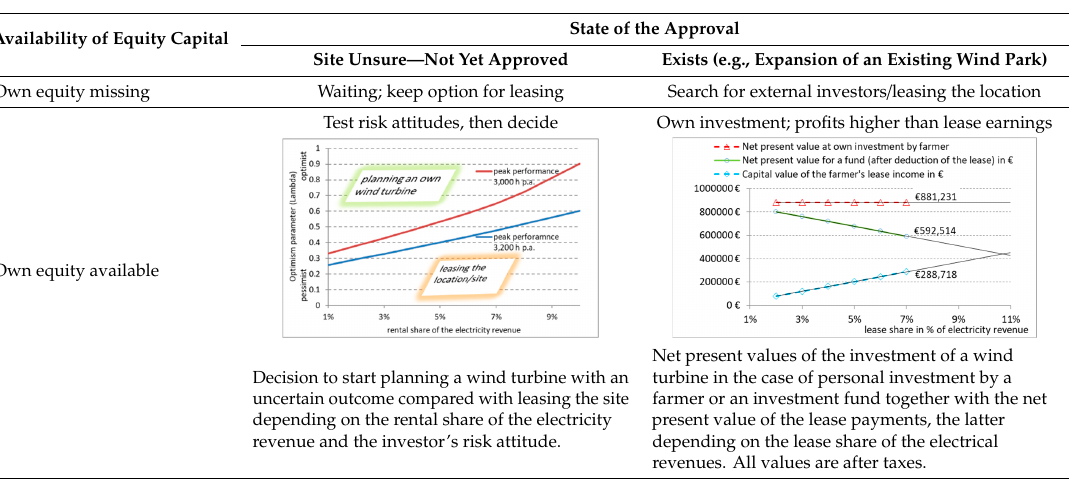
Table 4. Recommendations for investment decisions or leasing wind turbine sites depending on the state of the approval, the availability of equity capital, the risk adjustment, and the possible lease revenue (example for a 3200 h peak performance wind